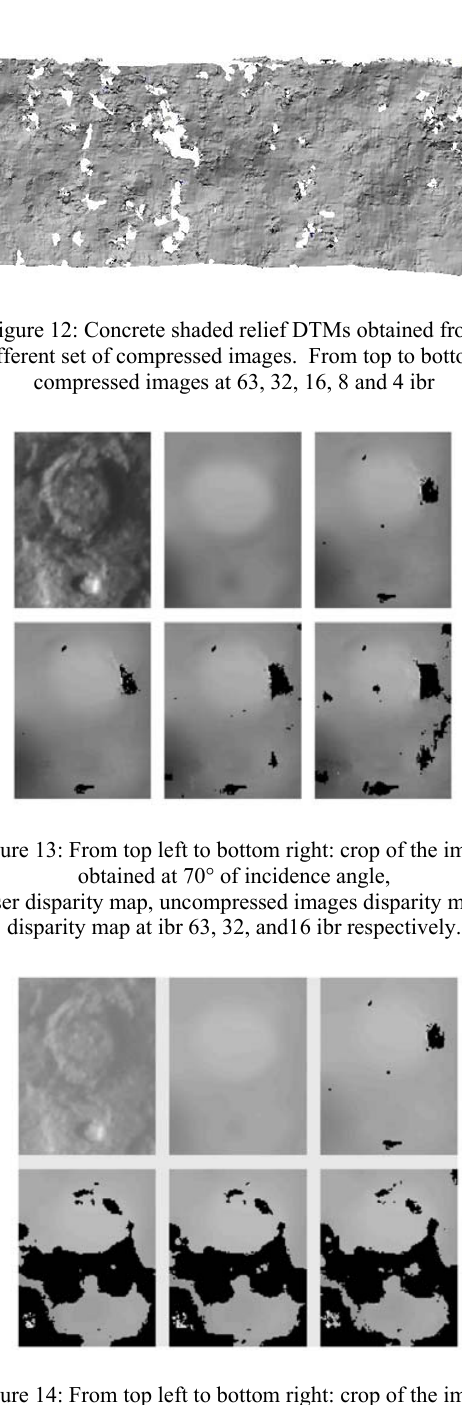
Figure 14: From top left to bottom right: crop of the image obtained at 10° of incidence angle, laser disparity map, uncompressed images disparity map, disparity map at ibr 63, 32, and16 ibr respectively.